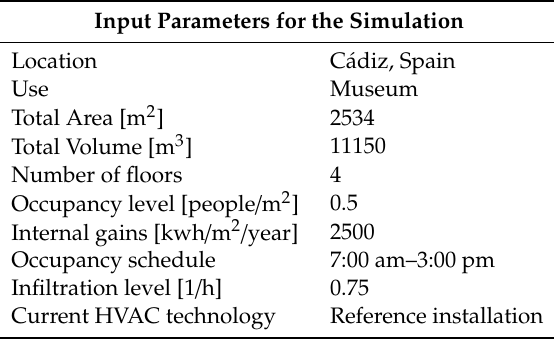
Table 2. Main input parameters for the dynamic simulation of the case study building.